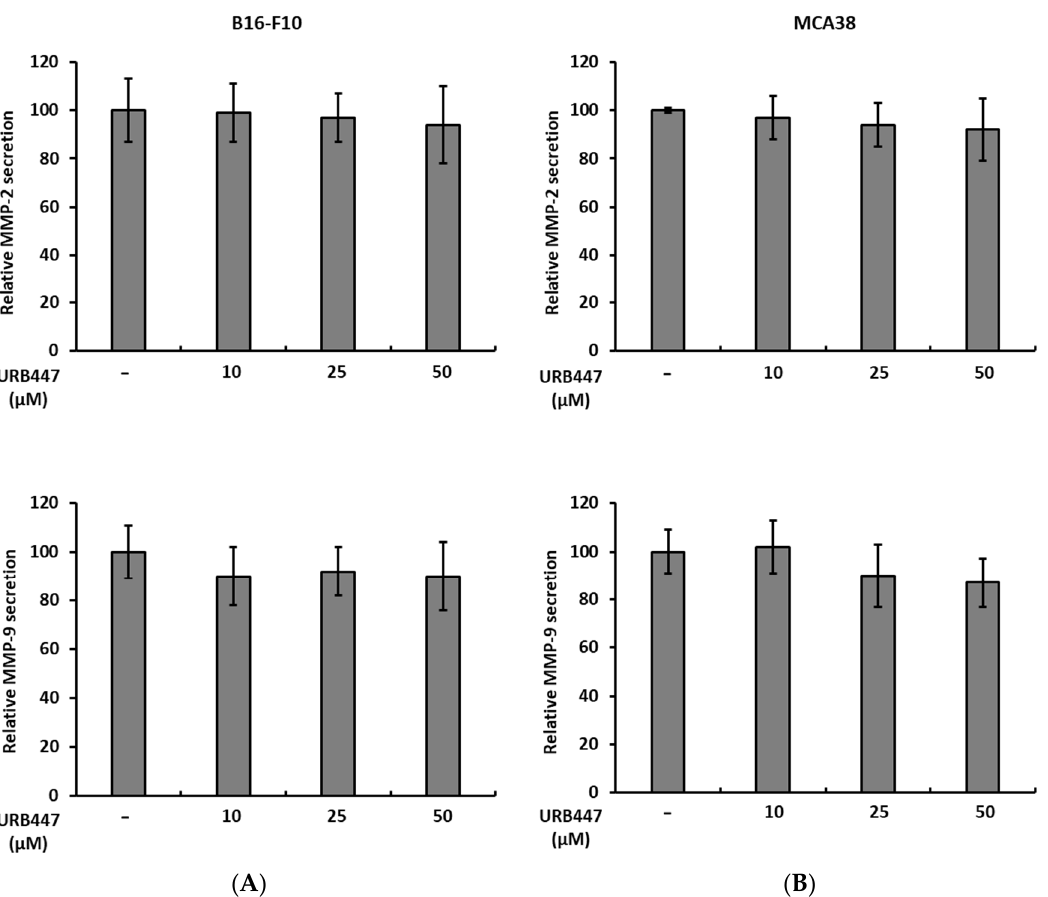
Figure 6. Secretion of MMP-2 and MMP-9 in URB447 treated tumor cells. The secretion of MMP-2 was measured in melanoma ( A ) and CRC cancer cells ( B ) in the presence of increasing concentrations of URB447 for 24 h. ( n = 3). No significant differences were observed.